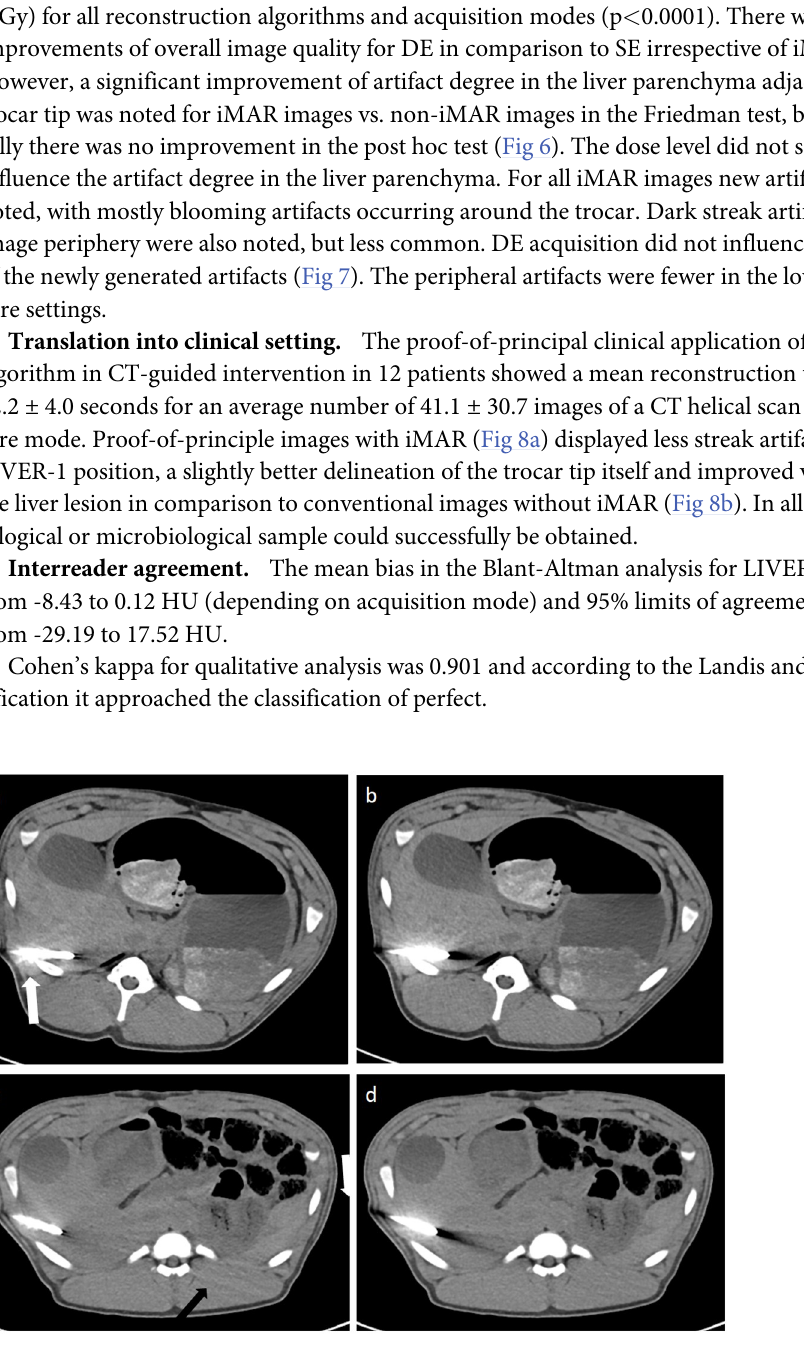
Fig 7. Image examples of iMAR effects and of newly generated artifacts by iMAR. iMAR images showed significantly less artifacts around the trocar tip and in the liver parenchyma bordering to the trocar tip (a and c). Blooming artifacts (white arrow) were most prominent around the trocar (a) in comparison to non-iMAR images (b). Peripheral streaks (black arrows) were observed at the image periphery with iMAR (c) in comparison to the corresponding non-iMAR image